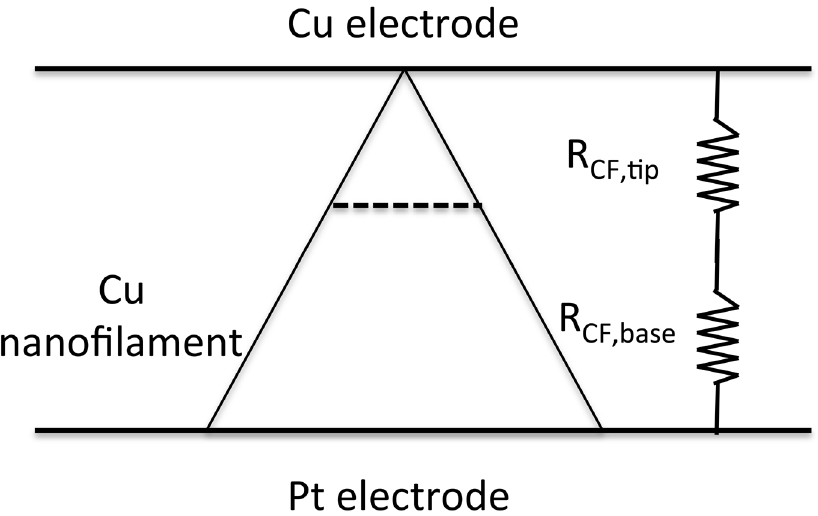
Figure 7. The total resistance R CF of the cone or pyramidal shaped nanofilament consists of the sum of the tip and base segments: R CF = R CF,tip + R CF,base . Because of the atomic construction at the tip R CF,tip > > R CF,base